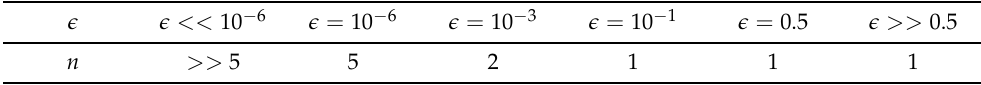
Table 8. Applying the FPA to find n for various (cid:101) and x = 0.2.